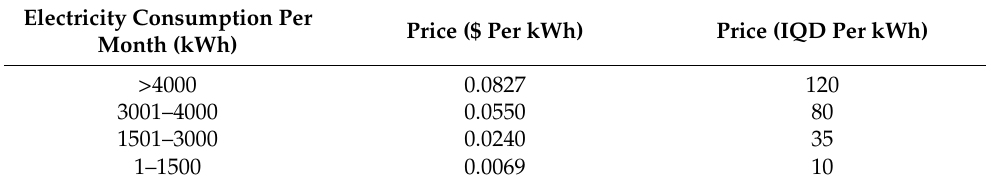
Table 3. National grid residential electricity prices.